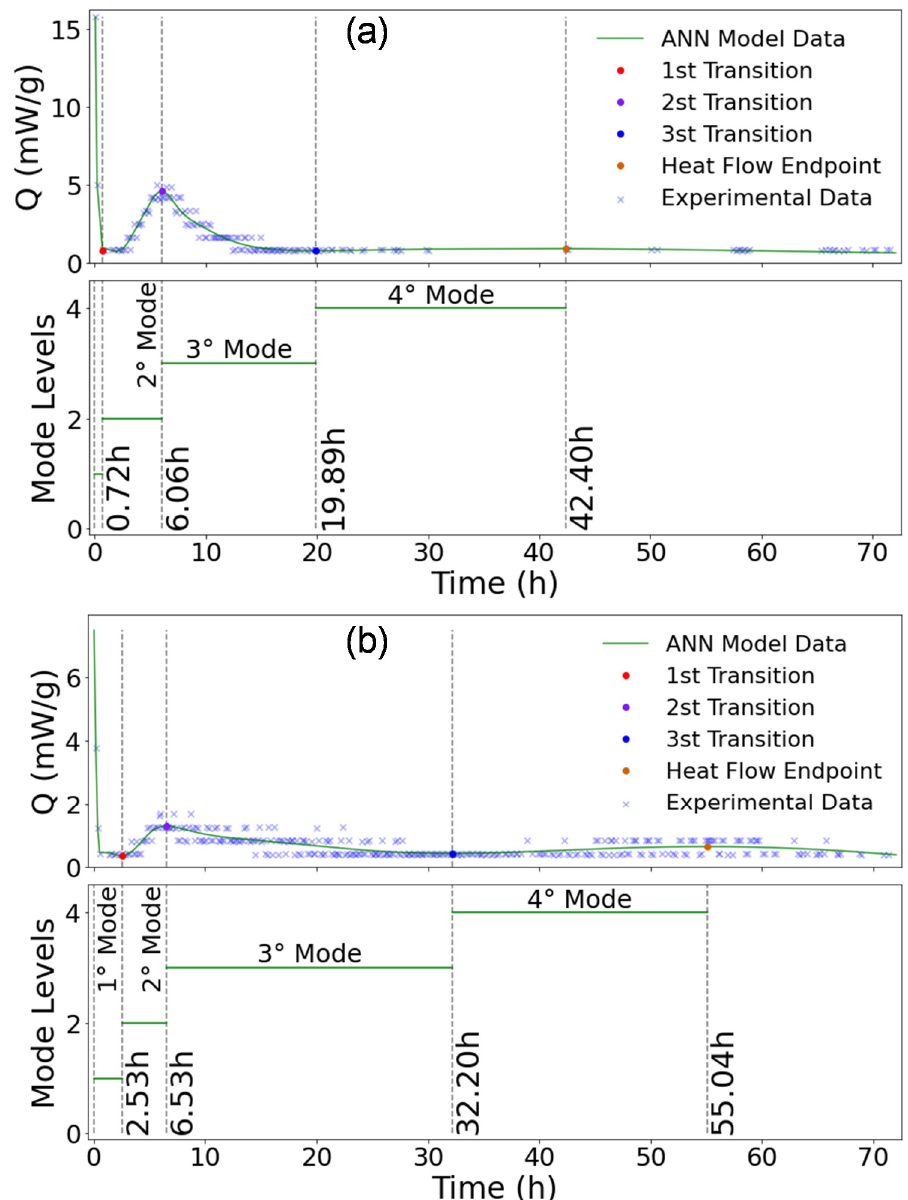
Figure 14. Heat of hydration, ANN model generated, modes, and transitions identification: ( a ) CEM III and ( b ) CEM III + GP. ( a ) CEM III and ( b ) CEM III +